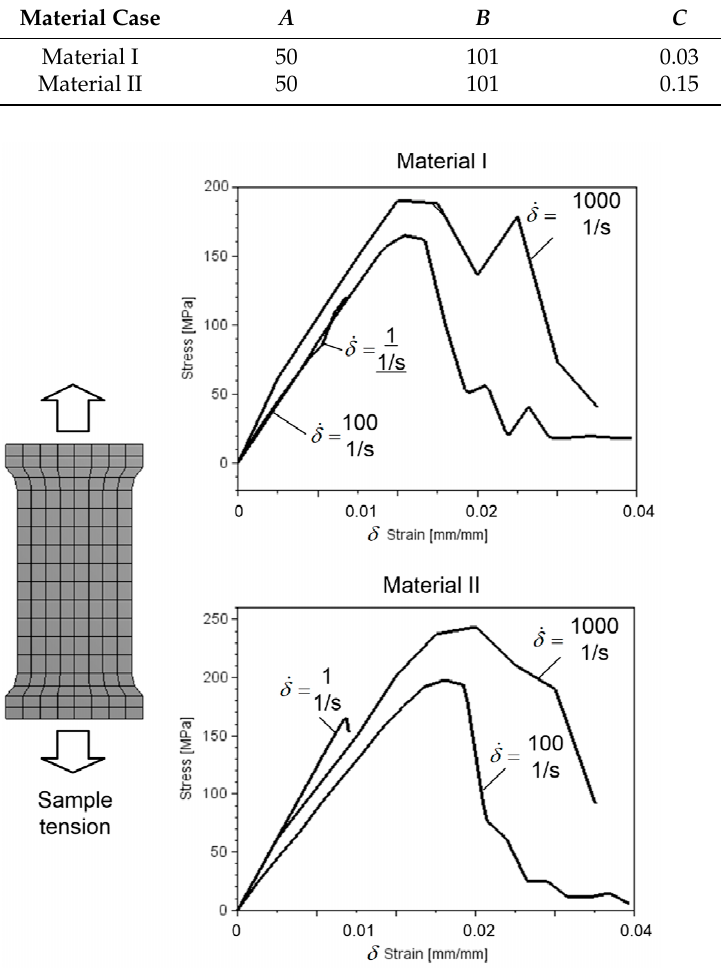
Figure 3. The Strain-Stress relationship (SSR) for two selected material models [26].